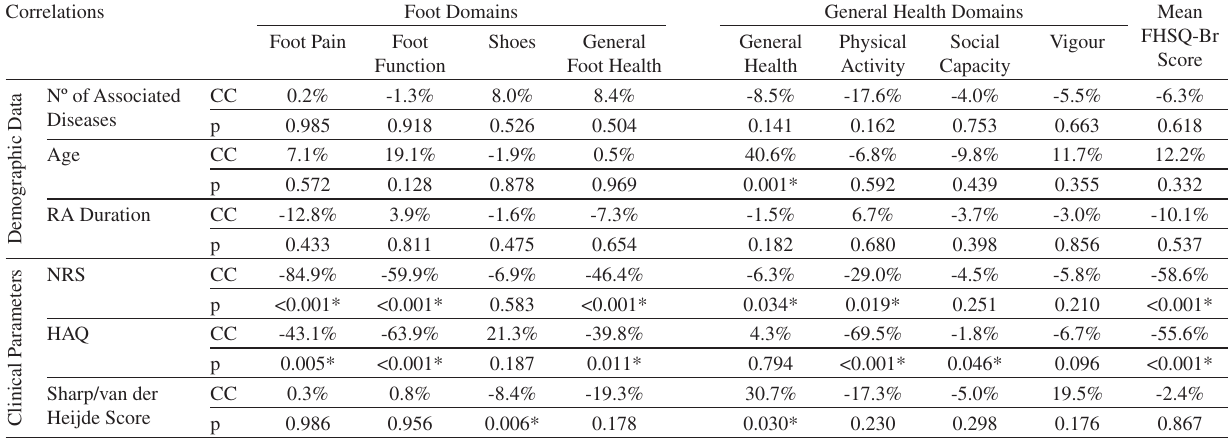
Table 5 - Correlation coefficients and p-values for the analyses �etween the domains of the FHSQ-Br and the clinical parameters of the study group